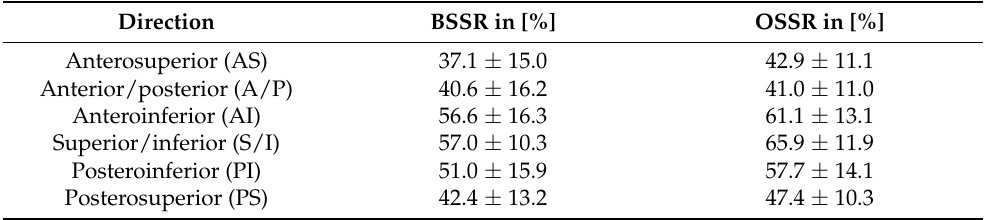
Table 2. Results of BSSR and OSSR in % for glenoid directions considered. Results are presented as mean ± standard